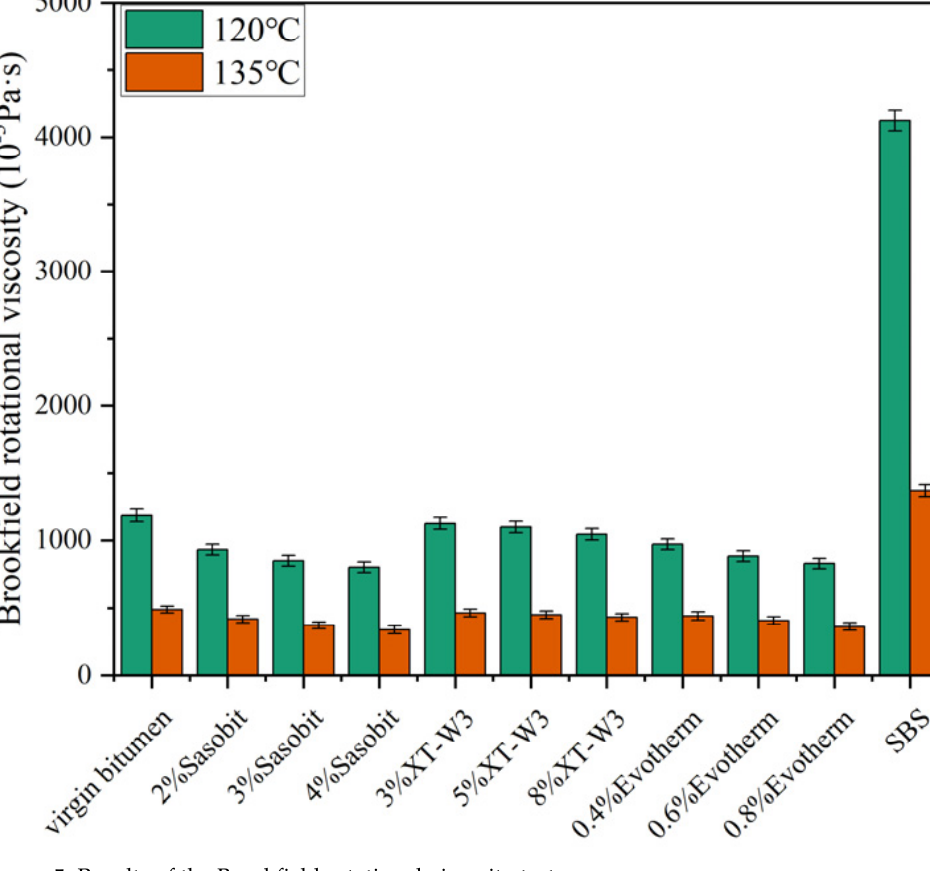
Figure 5. Results of the Brookfield rotational viscosity test.